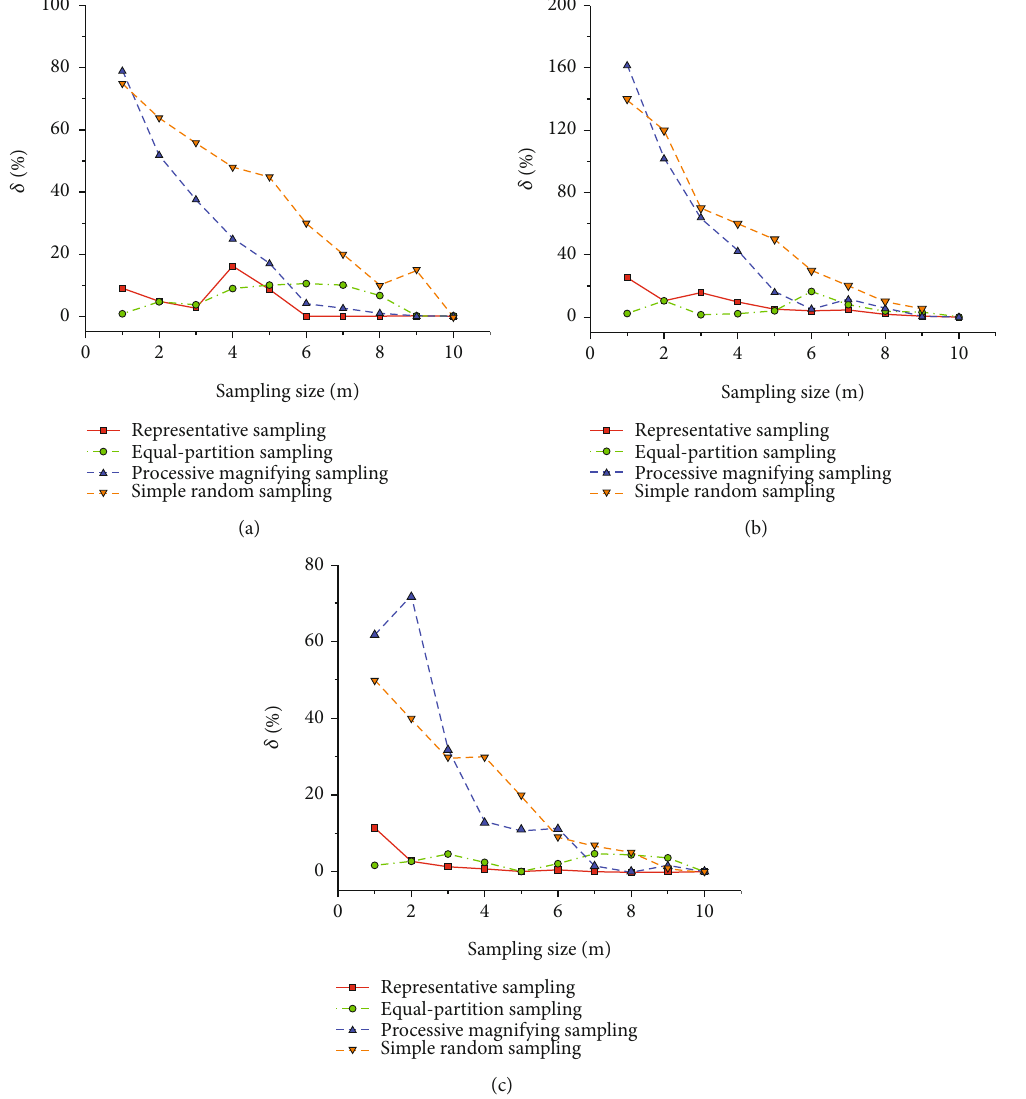
Figure 7: The relative error of di ff erent sampling methods applied in three sets of jointed rock masses: S1; S2;